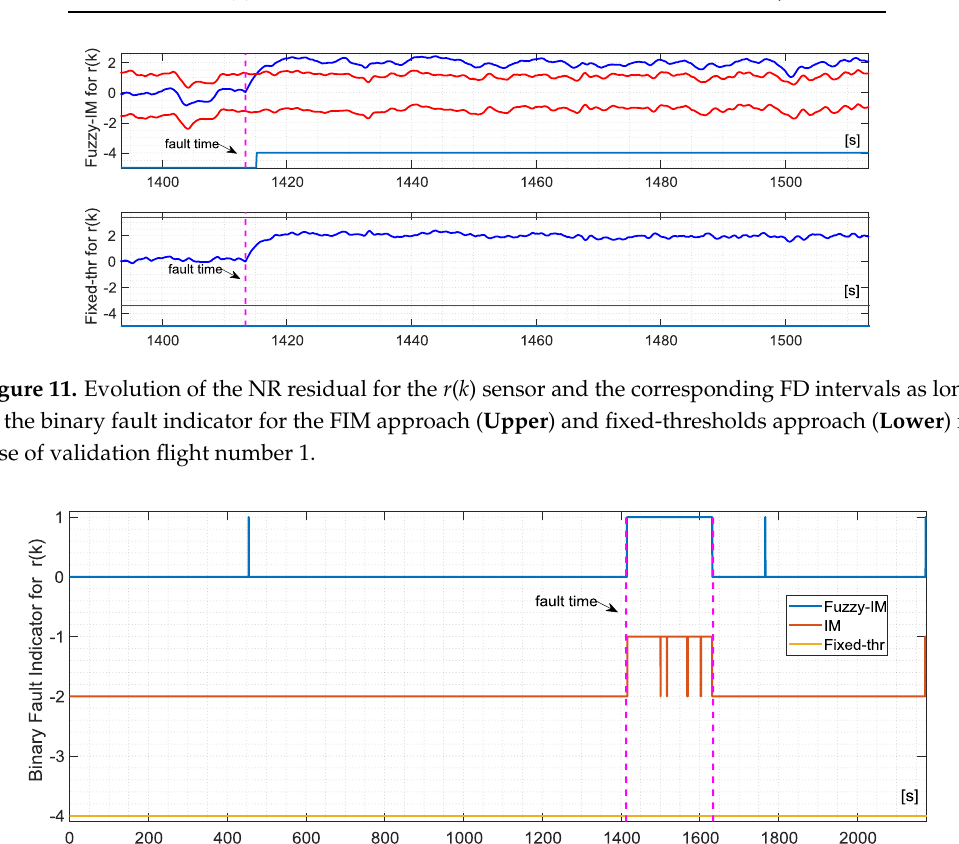
Figure 12. Evolution of the FIM, IM and FTM binary fault indicators for validation flight 1 in case of